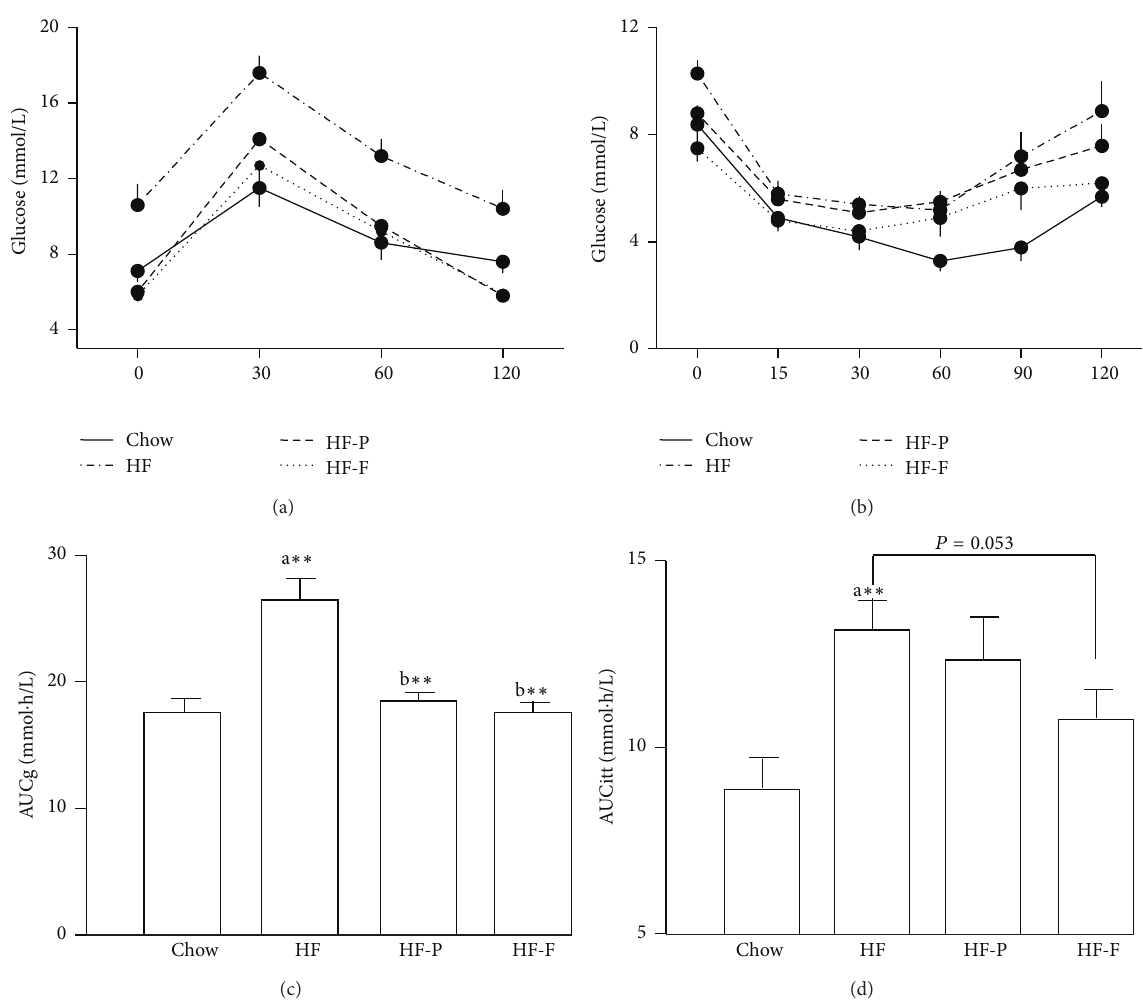
Figure1:PPARagonists’treatmentimprovedglucosetoleranceandinsulinsensitivityinhigh-fatdiet-inducedobesemice.Micewerefedwith either a normal chow diet (Chow) or a high-fat diet (HF) for 20 weeks and treated with either pioglitazone or fenofibrate. (a) Intraperitoneal glucose tolerance test (GTT), (b) insulin tolerance test (ITT), (c) AUC of GTT, and (d) AUC of ITT. HF-P: mice fed a high-fat diet and treated with pioglitazone; HF-F: mice fed a high-fat diet and treated with fenofibrate. a: versus Chow and b: versus HF; ∗∗ 𝑃 < 0.01 ; 𝑛 = 7 .